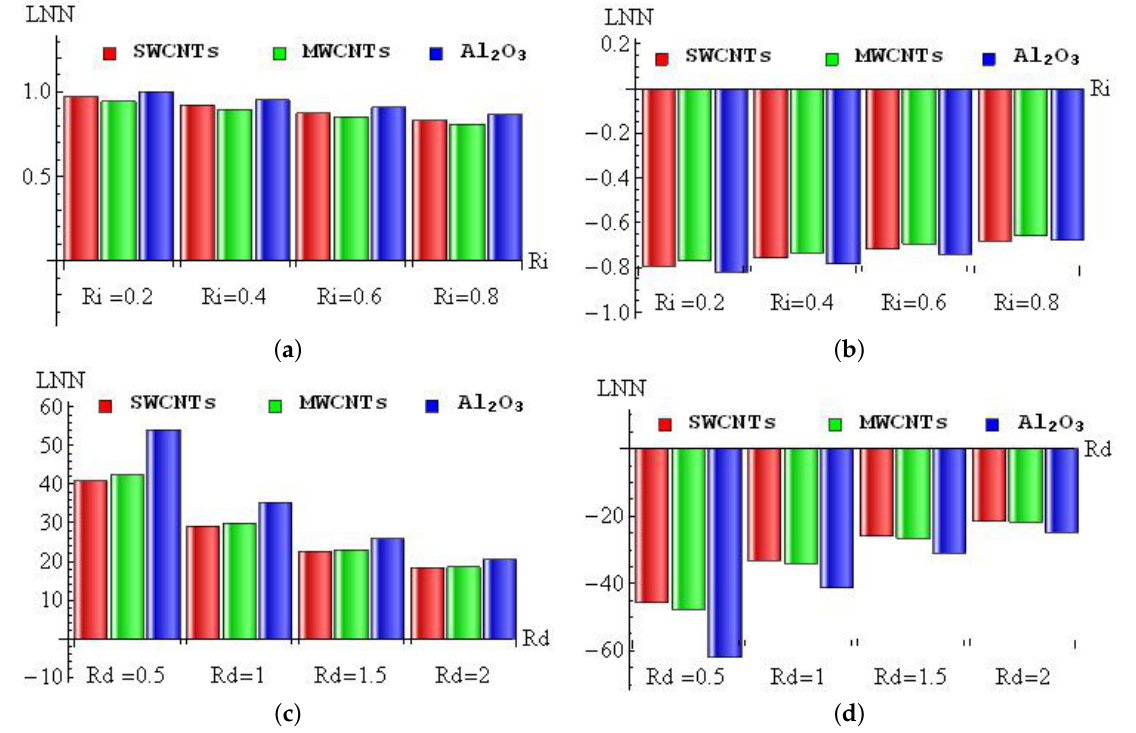
Figure 12. The diminishing/improving percentage of LNN for Ri ( a , b ) and Rd ( c , d ) with convective heating ( a , c ) and convective cooling ( b , d )